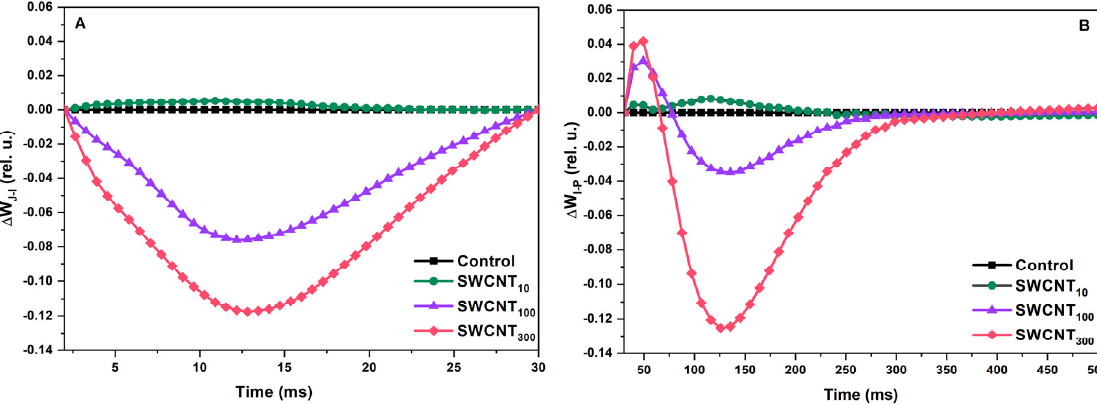
Figure 2. Differential curves constructed for the J-I ( A ) and I-P ( B ) phases of the prompt Chl fluorescence transients of pea plants sprayed with distilled water (control), 10, 100 and 300 mg/L SWCNT. The differential curves were obtained by subtraction of the control J-I and I-P phases from the respective ones of treated plants following normalization between the J and I or I and P points, respectively: Δ WJI = W JItreated –W JIcontrol and Δ W IP = W IPtreated –W IPcontrol .